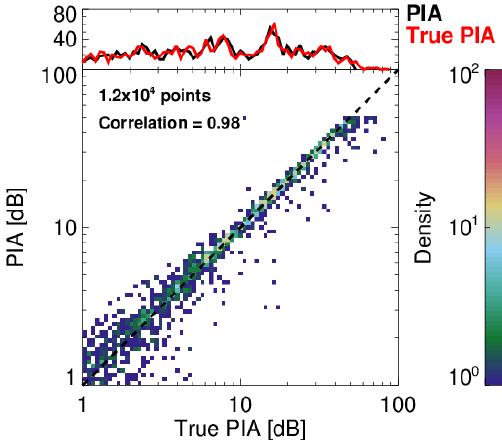
Figure 3. Scatter plot of the estimated C-FMR PIA and the true PIA from the three scenes from